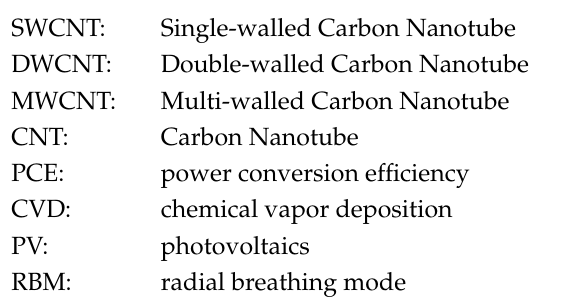
Figure S1: Dark J/V curves for cells for each type of sample after the second HF etch: ( a ) SWCNT-1; ( b ) SWCNT-2; ( c ) DWCNT; and ( d ) Sigma Aldrich MWCNT. Figure S2: A plot of the relation between J SAT and V OC for the best performing cells for each sample. Table S1: Sheet resistance as a function of thickness. The values marked with an asterisk were the volumes used to produce films for solar cells in this